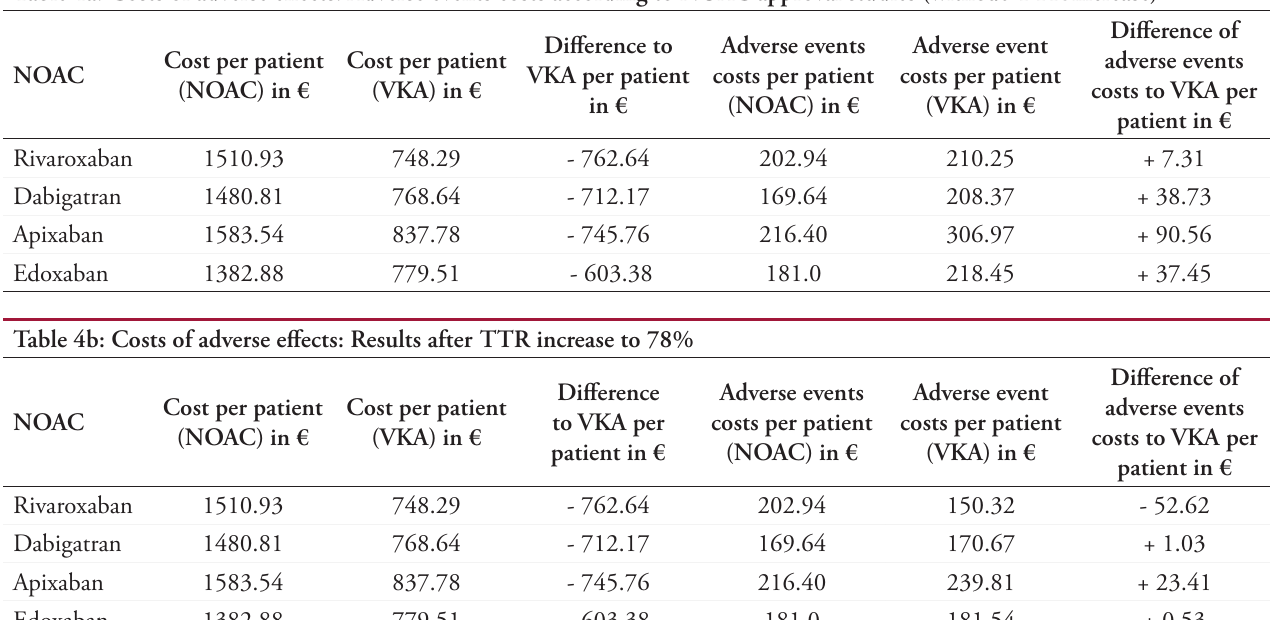
Table 4a: Costs of adverse effects: Adverse events costs according to NOAC approval studies (without TTR increase) NOAC